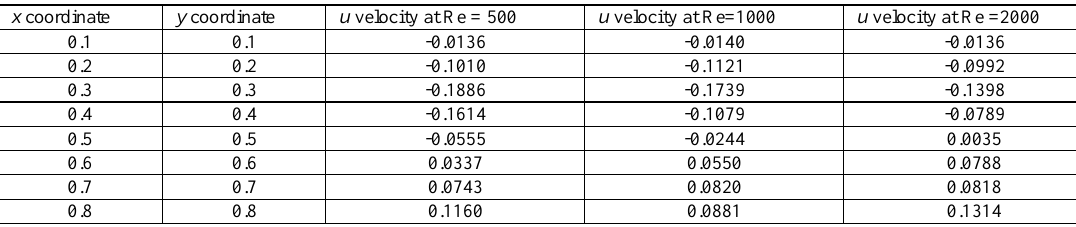
Table 1. u -velocity at different nodes and different values of Re at t =15